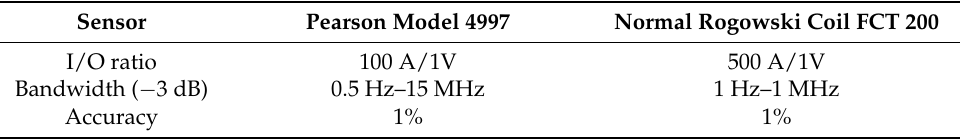
Table 9. The main specifications of two commercial